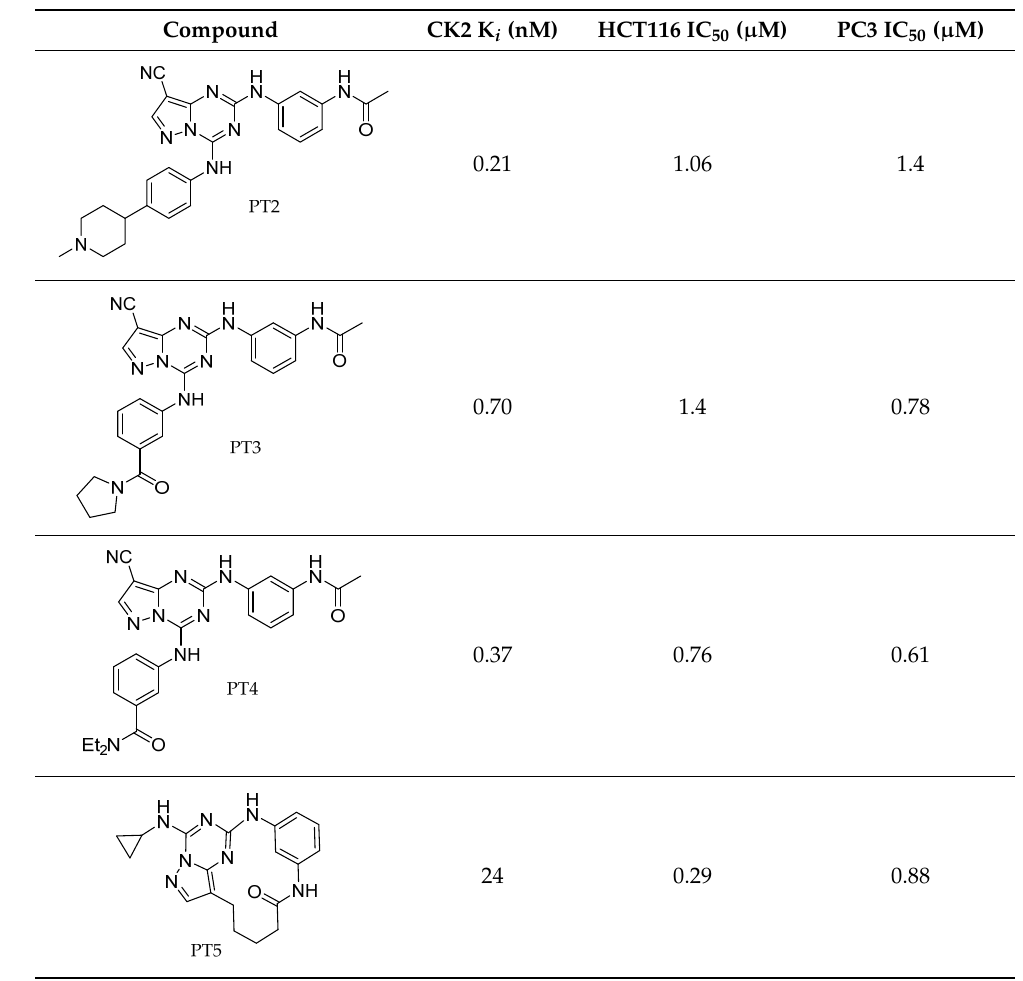
Table 3. Comparison of the K i ’s and IC 50 ′ s (HCT116 and PC3) of four pyrazolo-triazine CK2 inhibitors: PT2, PT3, PT4 and PT5 [63,94].